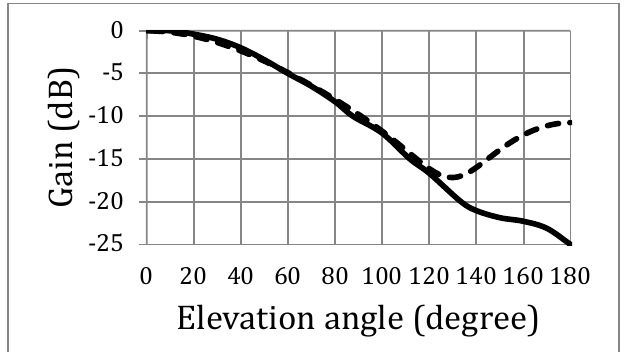
Fig. 13. RHCP normalized radiation pattern at 1.6 GHz: solid – measured, dashed –